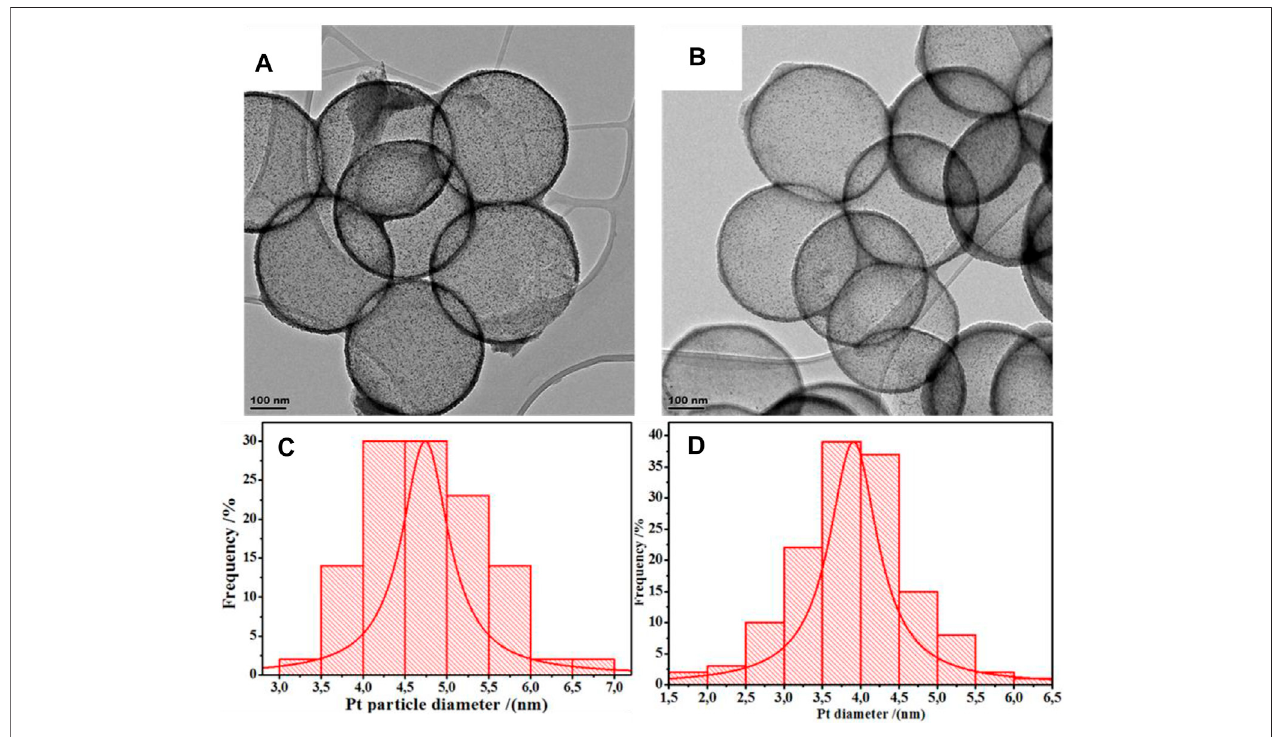
FIGURE 1 | TEM image of (A) Pt/HCSs, (B) Pt/NHCSs, and particle size distribution of Pt on Pt/HCSs (C) , and particle size distribution of Pt on Pt/NHCSs (D) .